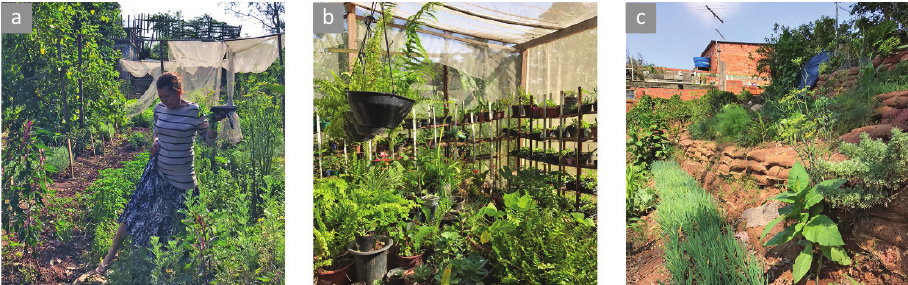
Figure 8. Vila Nova Esperança, São Paulo: (a) community leader Lia Esperança in the organic food garden; (b) greenhouse; (c) slope